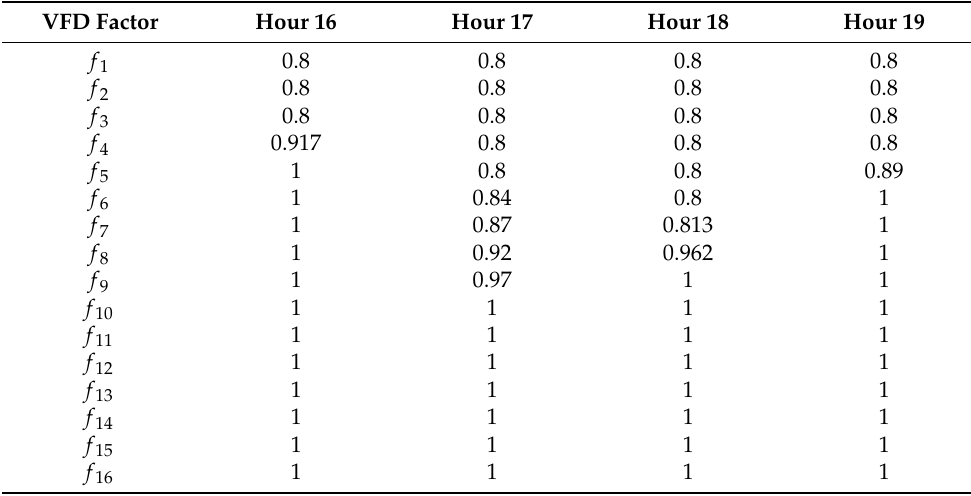
Figure 12. The RO energy consumption optimization. Table 3. The VFD factor f patterns for the peak load hours.